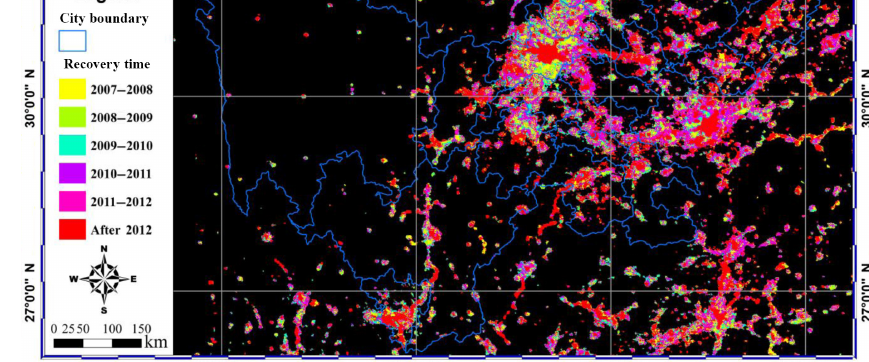
Figure 7. The time of light recovery.